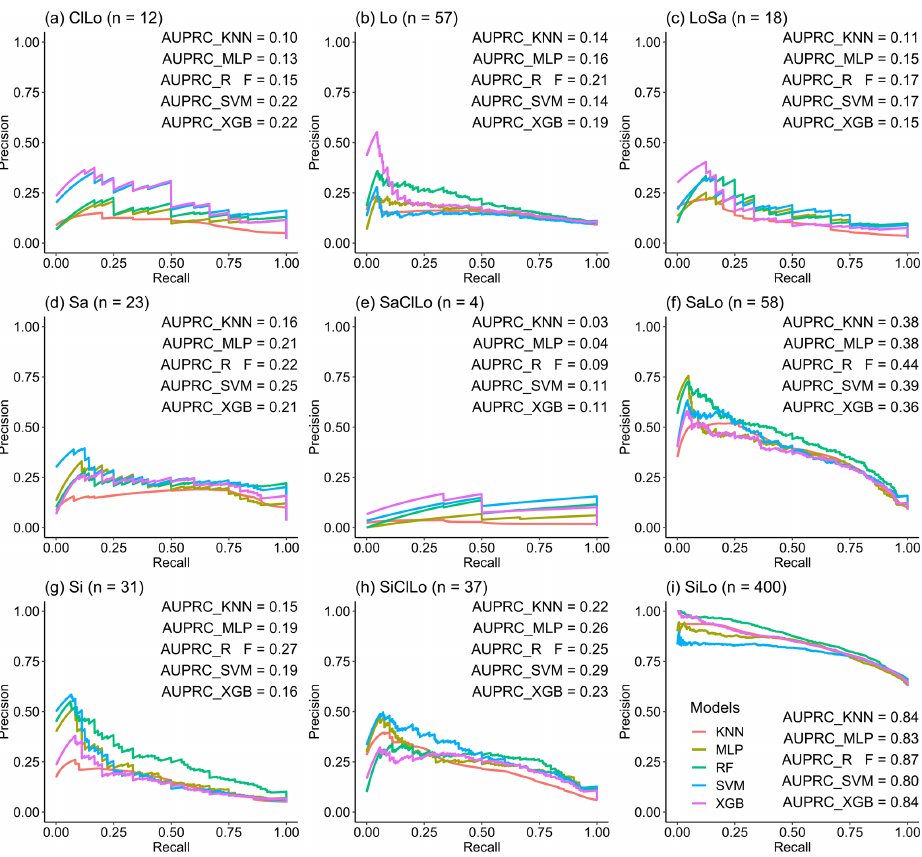
Figure 4. The AUPRCs for different machine-learning models in the prediction of each soil texture type: (a) ClLo, (b) Lo, (c) LoSa, (d) Sa,